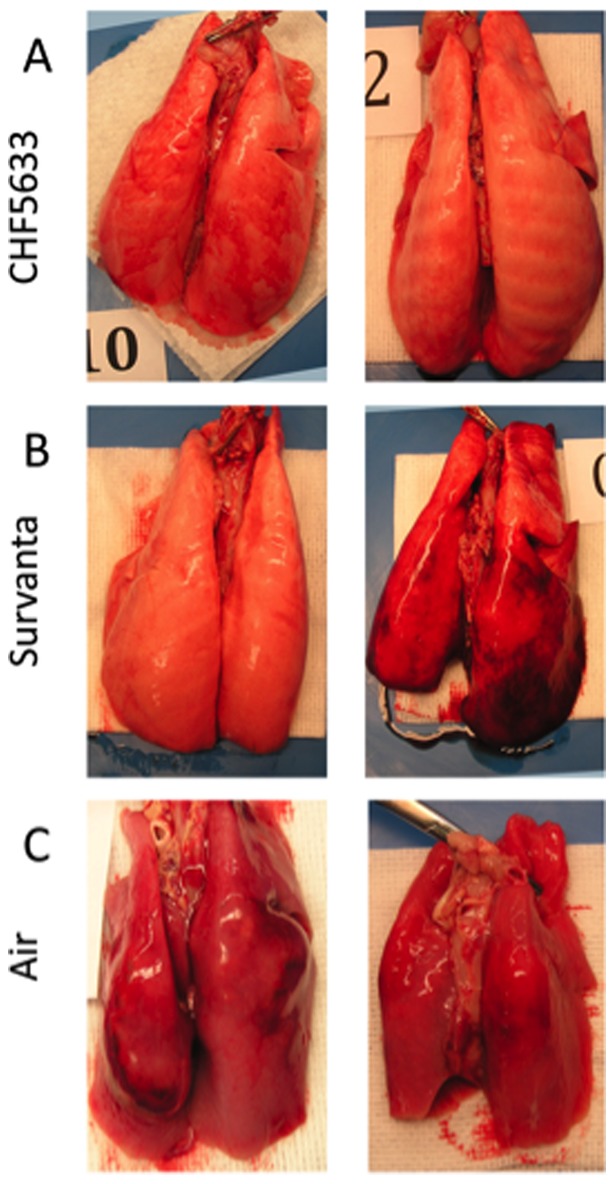
Lung appearance.Representative appearance of the lung for CHF5633 group (A), Survanta group (B), and Air group (C). CHF5633 expanded lungs uniformly for the most part. Half of the Survanta treated lambs had dark colored injured and small hemorrhagic areas in the lung. The lungs of the Air group were atelectatic with bullas.